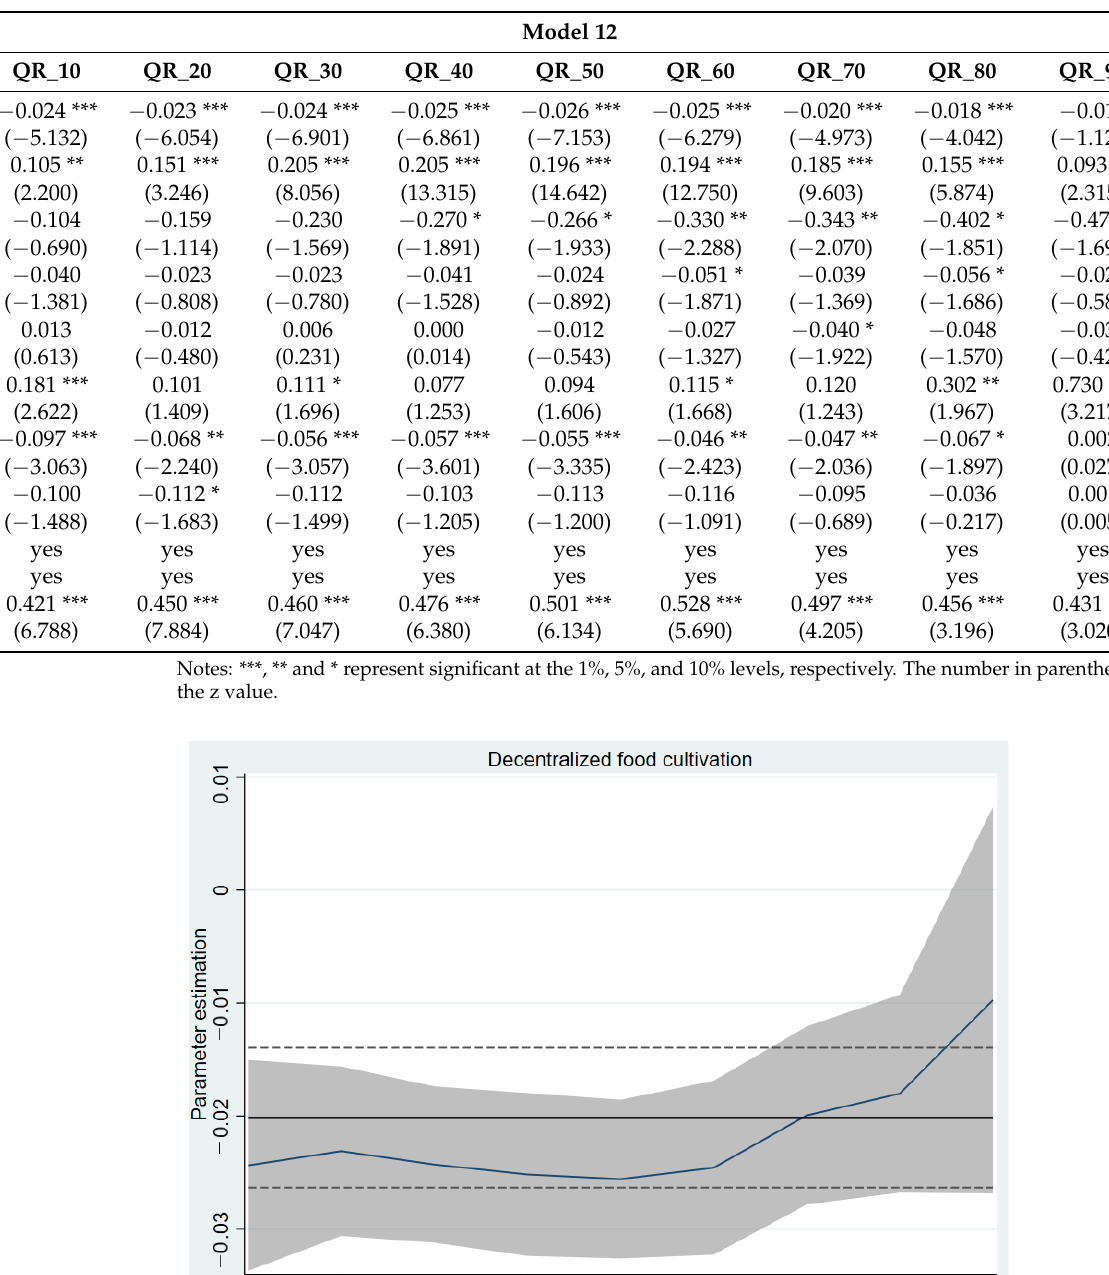
Table 5. Regression results of the quantile of decentralized food crop cultivation on the WLF nexus.